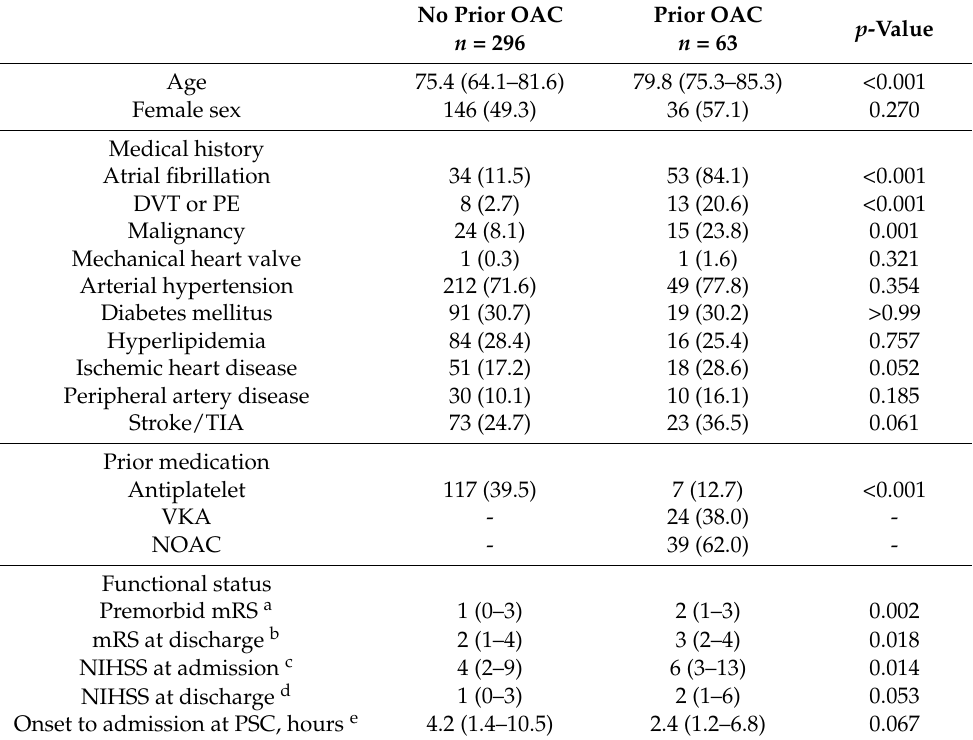
Table 1. Characteristics of patients with ischemic stroke categorized according to anticoagulation status at admission ( n =